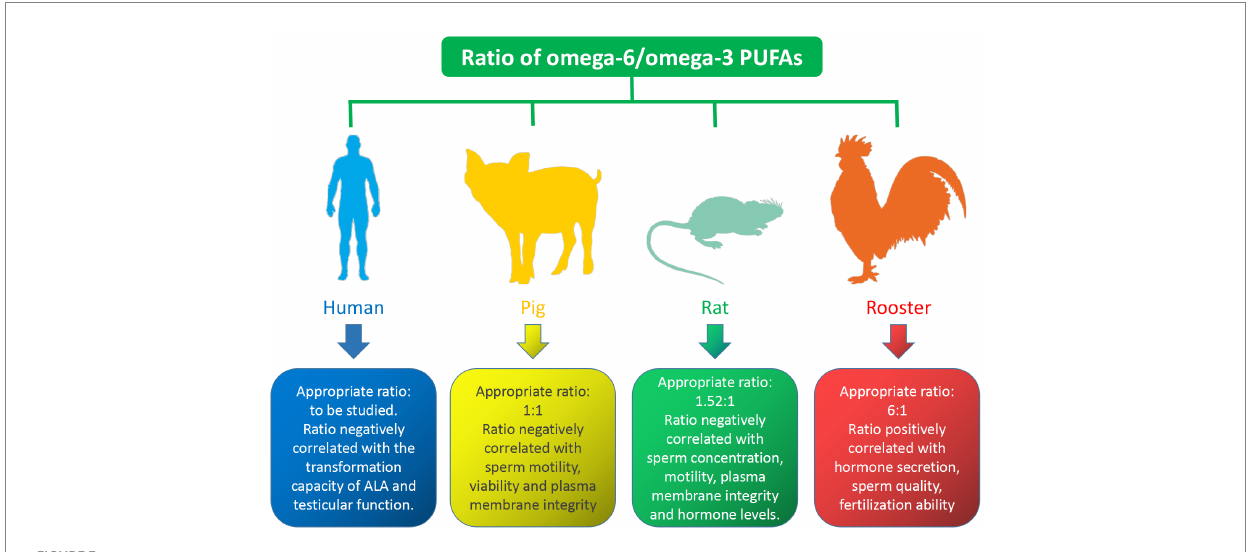
FIGURE 3 Effects of omega-6/omega-3 PUFAs on semen